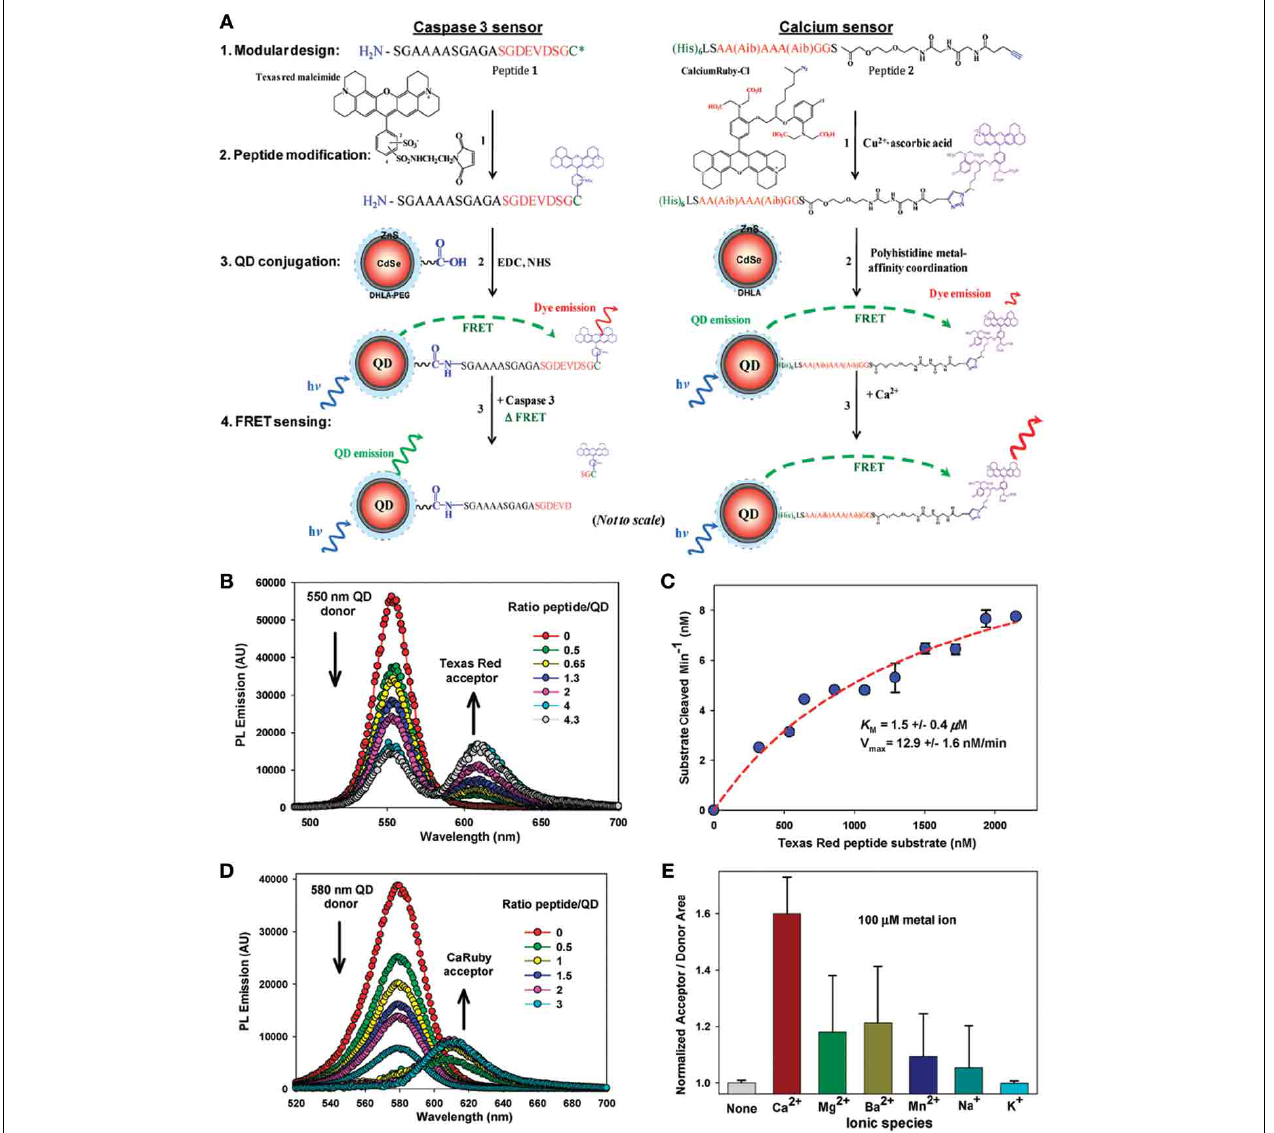
FIGURE 6 | Quantum dot protein biosensors. (A) Schematic showing the common design, chemical and sensing elements, including FRET-based biosensors: (1) peptide modularity, (2) peptide labeling, (3) attachment to QDs, and (4) FRET-based sensing for both the caspase 3 proteolytic sensor (left) and Ca 2 + sensor (right). The 4-pendant carboxyl groups that interact with Ca 2 + ions are shown in red on the CaRbCl structure. Within the Ca 2 + sensor peptide sequence, Aib is the synthetic amino acid α -aminoisobutyric acid. Reactive dye structures are shown where appropriate along with the chemical linkages attaching them to the peptides. (B) Representative, superimposed spectra collected from 550nm emitting QD donors surface functionalized with 85:15 DHLAPEG600-COOH/DHLA-PEG750-OMe ligands and covalently conjugated to increasing molar ratios of Texas Red-labeled substrate